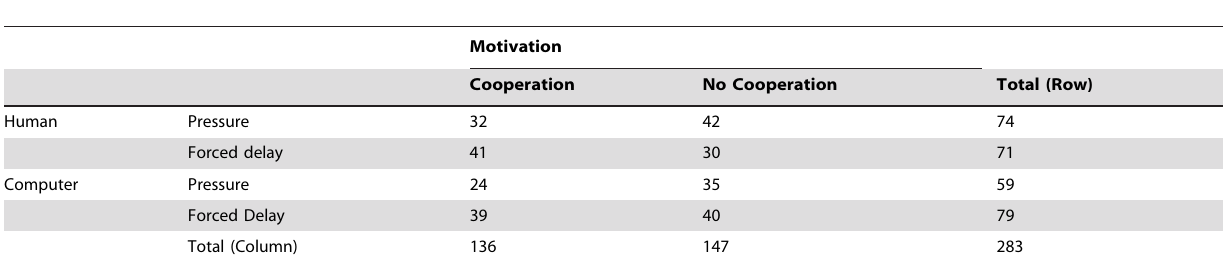
Table 3. Motivation Counts in as a Function of the Team Members and Decision Constraints in Experiment